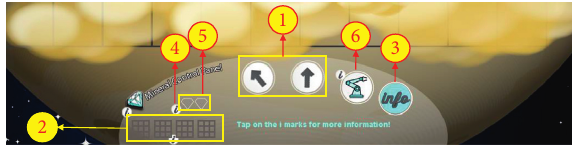
Figure 4: Individual control panels for the participant responsible for mining task: (1) the steering arrows; (2) the scans retrieved by the radar drone; (3) the info button enabling the information display; (4) the “ i ” sign showing/hiding the information tips; (5) the icons indicating number of needed/collected minerals (specific to the mineral control panel); (6) the claw button for retrieving the minerals (specific to the mineral control